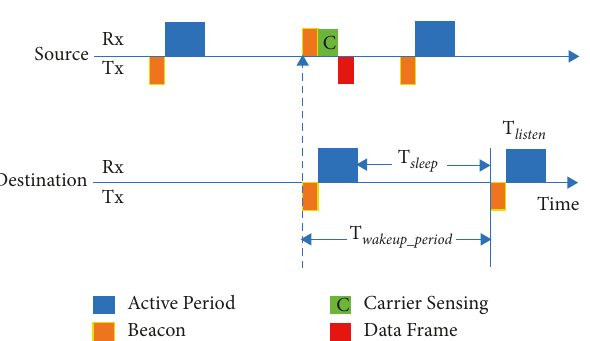
Figure 6: A synchronous periodic wakeup scheme adapted from the study by Ahmad et al.